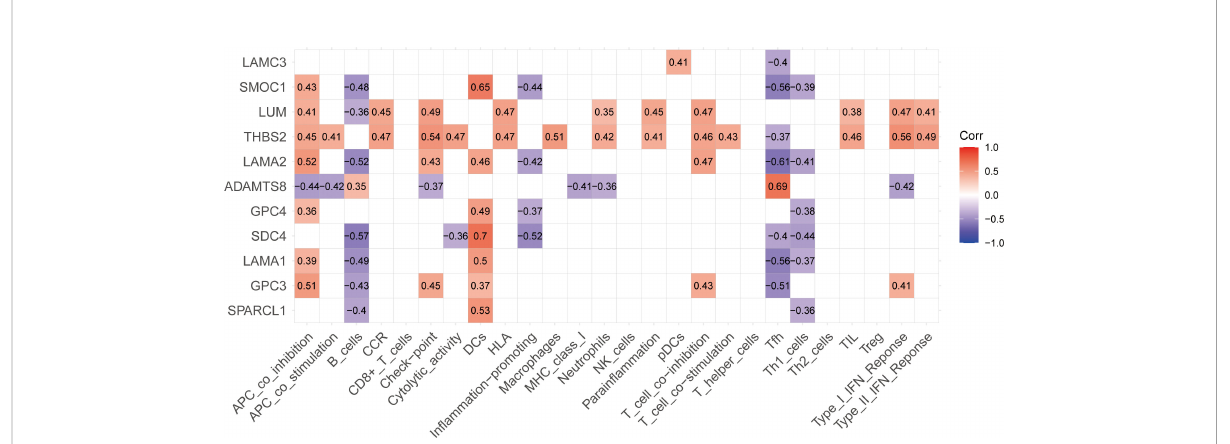
FIGURE 7 Correlation rectangle diagram for 11 BM genes and immunity showing correlations between the 11 BM genes and immunity including immune cells and immune functions; red indicates a positive correlation, purple indicates a negative correlation and the number in the box is the correlation coef fi